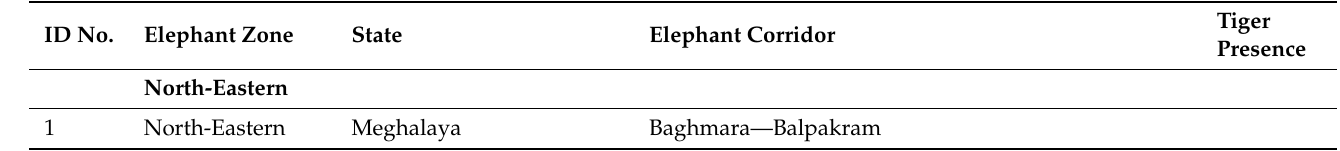
Table A1. List of elephant corridors and tiger presence records. (‘+’ signifies tiger